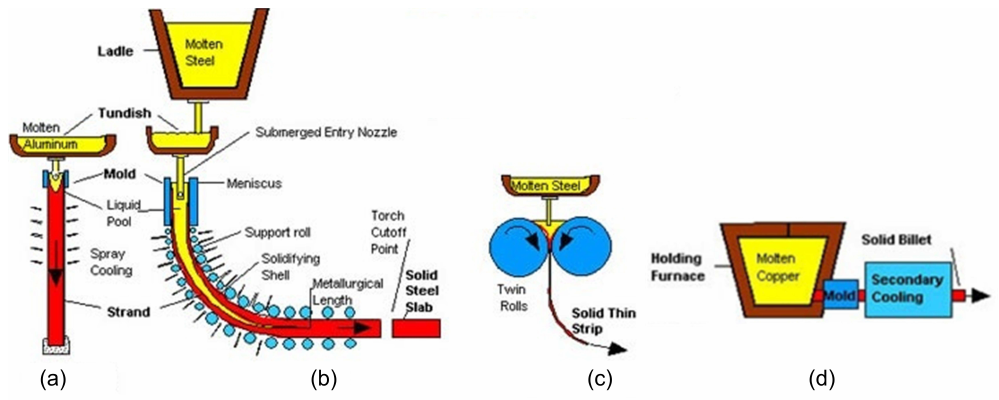
Figure 1. Continuous casting: ( a ) vertical; ( b ) curved; ( c ) strip; and ( d ) horizontal. Reproduced with permission from Brian G. Thomas, 2018